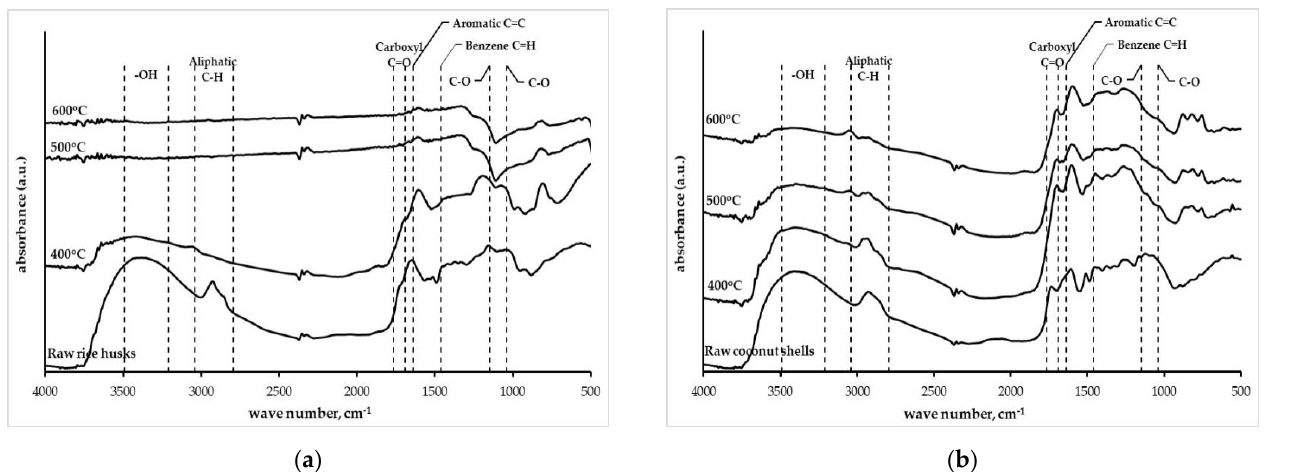
Figure 5. FTIR spectra of biochar of ( a ) rice husks and ( b ) coconut shells.